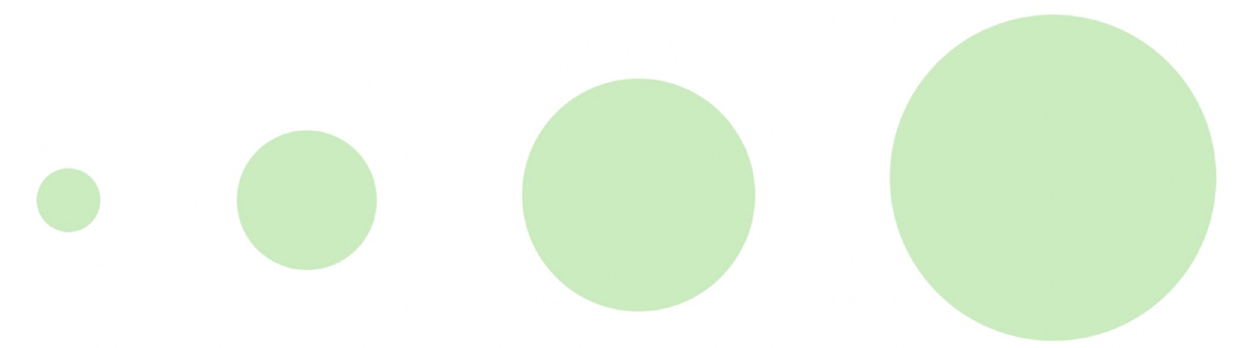
Fig 1. Subjective level of thirst scale.